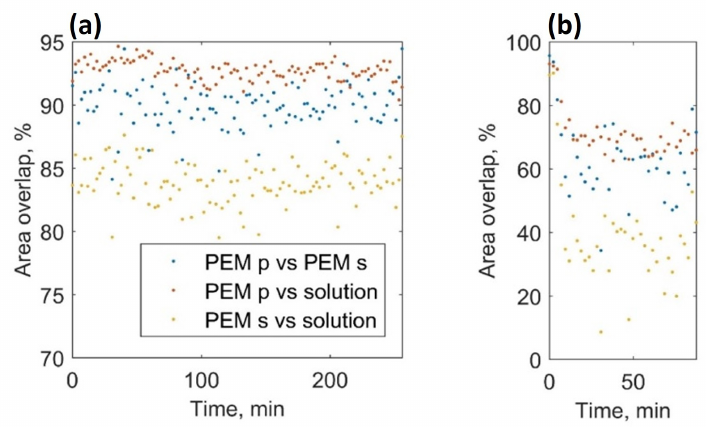
Figure 5. Time course of area overlap between spectrum of Lys loaded to the PEM-coated crystal and spectrum of Lys in solution during adsorption ( a ) and desorption ( b ).